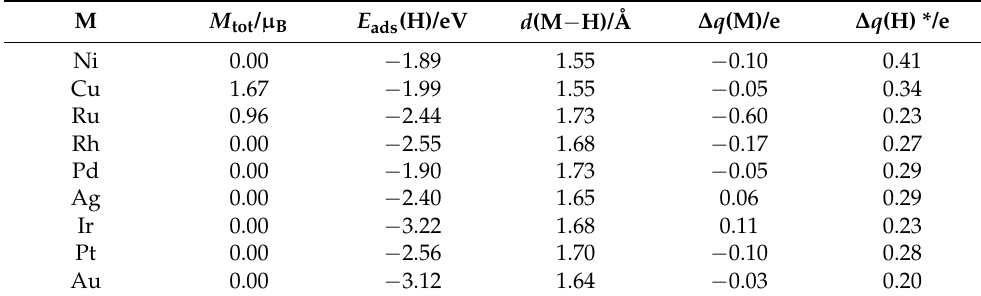
Table 2. The H adsorption onto M@vG at the M-top site: total magnetizations ( M tot ), H adsorp- tion energies ( E ads (H)), relaxed M − H distance ( d (M − H)), change of the Bader charge of M upon adsorption ( ∆ q (M)) and change of the Bader charge of H upon adsorption ( ∆ q (H)).